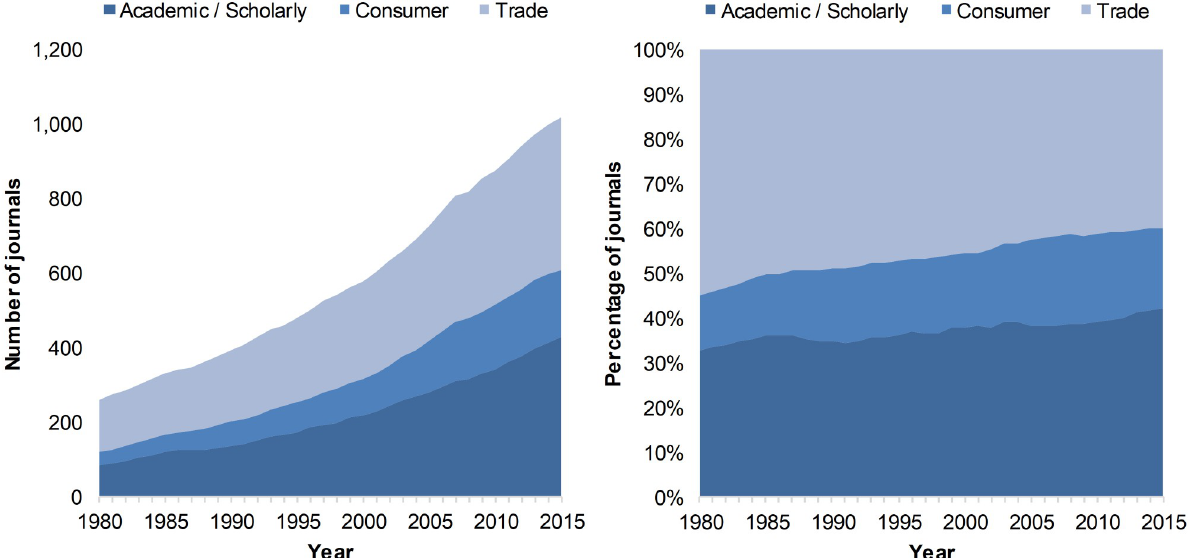
Fig 1. Number (left) and proportion (right) of scholarly journals devoted to architecture published worldwide, by year of founding and journal type, 1980–2015.